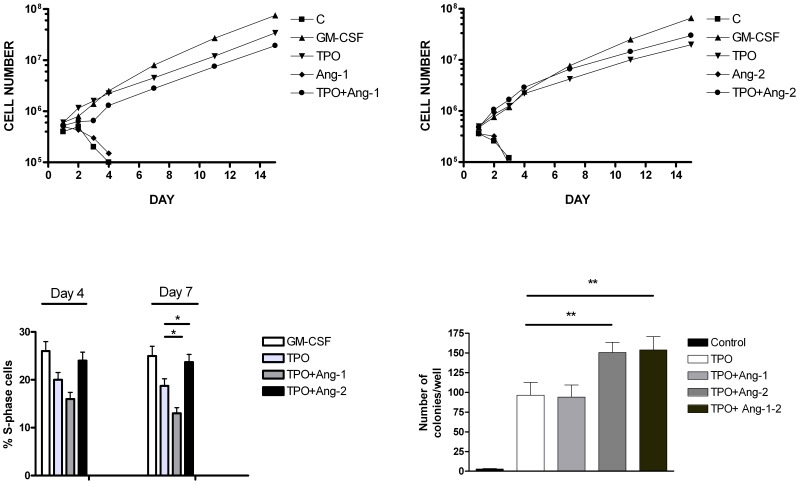
Effect of exogenous angiopoietins on the growth of UT7/mpl cells.
Top Panels: UT7/mpl cells have been grown either in the absence (C ) or in the presence of either GM-CSF, TPO, Ang-1, Ang-2, TPO+Ang-1 or TPO+Ang-2 and the number of living cells was determined at each day of culture. Bottom Panel, left: At day 4 and 7 of culture cell aliquots were harvested and analyzed for cell cycle by PI labeling and flow cytometry. The proportion of S phase cells (mean values ± SEM observed in three separate experiments) is reported. * p<0.05 Bottom panel, right: UT7/mpl cells have been plated in methylcellulose either in the absence (control) or in the presence of either TPO, TPO+Ang-1, TPO+Ang-2 or TPO+Ang-1+Ang-2 and after 10 days of in vitro culture the number of colonies was evaluated under an inverted microscope. Mean values ± SEM observed in three independent experiments are shown. ** p<0.01.